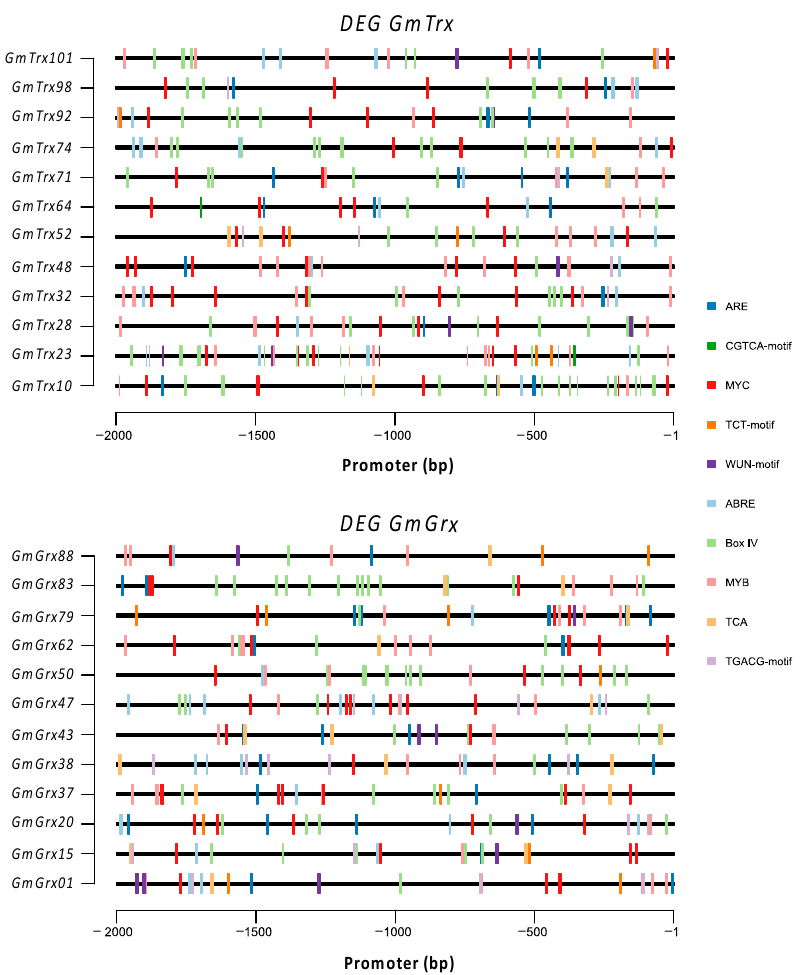
Figure 5. Number and localization of the more frequent cis-acting elements among the GmTrx and GmGrx family in the promoter regions of the DEGs. The 2000 bp genomic upstream of the Transcriptional Start Site (TSS) of GmTrx and GmGrx sequences were analyzed with PlantCARE [27], in order to predict their cis-regulatory elements (CRE). The cis-acting elements presented are labeled with different colors and illustrated on the right side. The TATA-box and CAAT-box are not shown.